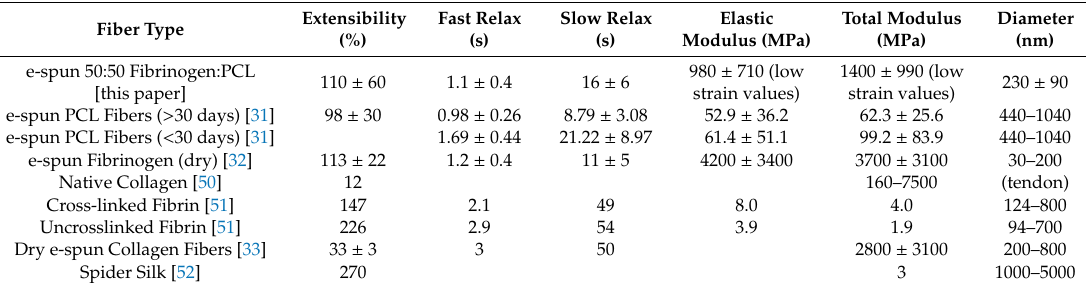
Table 2. Comparison of select properties from some relevant electrospun and natural